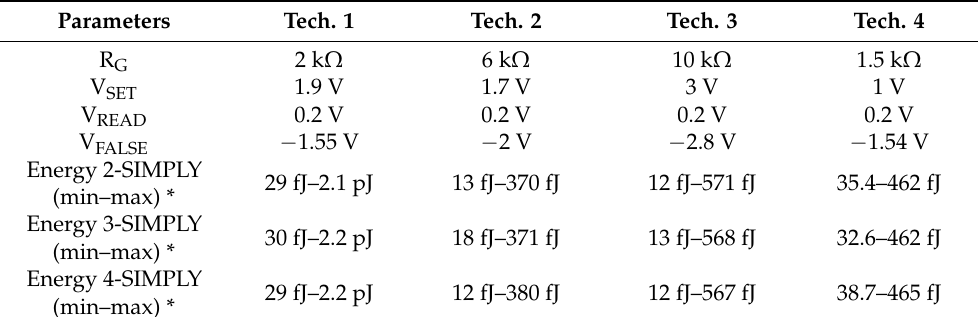
Table 3. Circuit parameters and energy consumption of n-SIMPLY operation (n = 2, 3, 4) with t pulse = 1 ns.